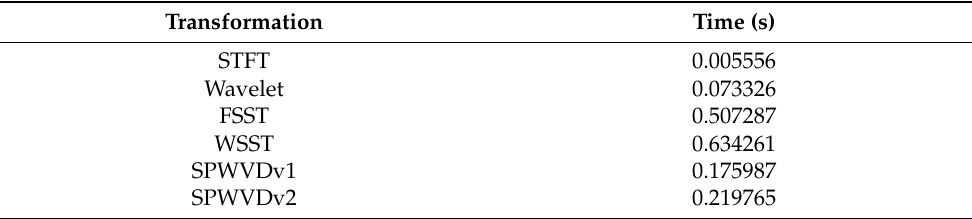
Table 2. Absolute computational times of each considered transformations for single MBN burst.